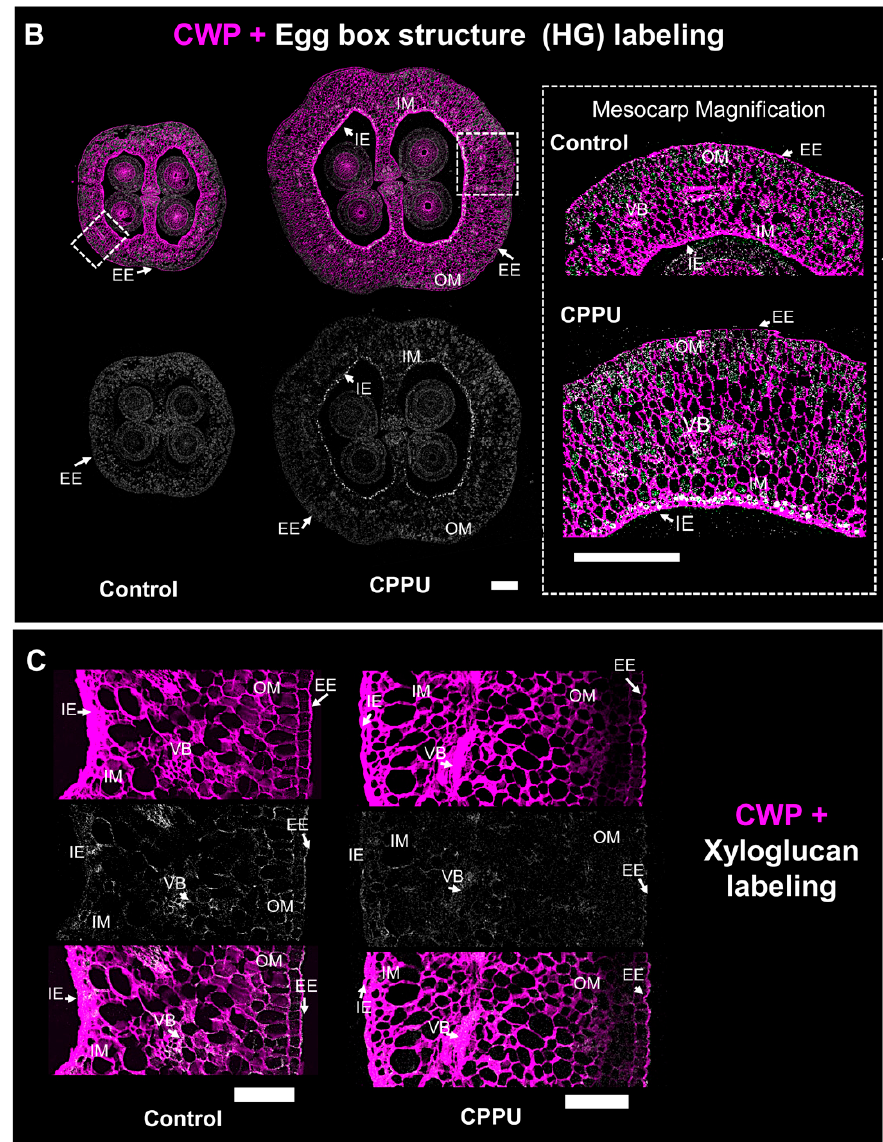
Figure 3. Pre-anthesis CPPU applications induce changes in ovary cell wall content at flowering stage. Immunolabeling of cross-sections from control and CPPU-treated ovaries: ( A ) Calcofluor White was applied to stain cell wall polysaccharides (CWP) (magenta), and a representative cross-section of each ovary is shown; scale bar: 200 μ m. The right figure exhibits the relative fluorescence signal of Calcofluor White as normalized values regarding total ovary area, and the results show mean ± SE from five biological replicates ( n = 5); asterisks indicate statistical significance as compared to con- trol condition and determined by Student’s t -test (*, p ≤ 0.05). ( B ) Cross-sections of ovaries were immunolabeled with 2F4 monoclonal antibody (gray) to target the egg-box structure. Scale bar: 200 µ m; a mesocarp magnification is displayed to evidence high signal in the internal epidermis (IE). IM = internal mesocarp; VB = vascular bundle; EM = external mesocarp; EE = external epidermis; OM = outer mesocarp. ( C ) Representative sections of the ovary wall immunolabeled with Calcofluor White (magenta) and LM15 monoclonal antibody (gray) to target the XXXG motif of xyloglucan. Im- ages of ovary were digitally extracted and placed on the same background for phenotype comparison. Scale bars = 200 µ